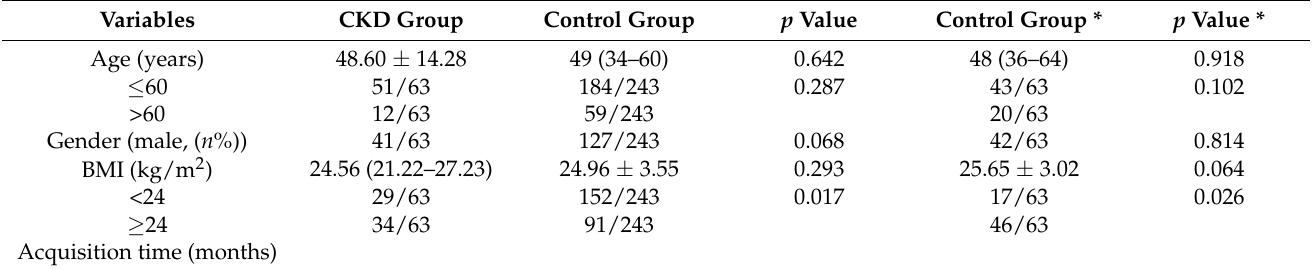
Table 2. Baseline characteristics of CKD patients receiving inactivated vaccine and healthy